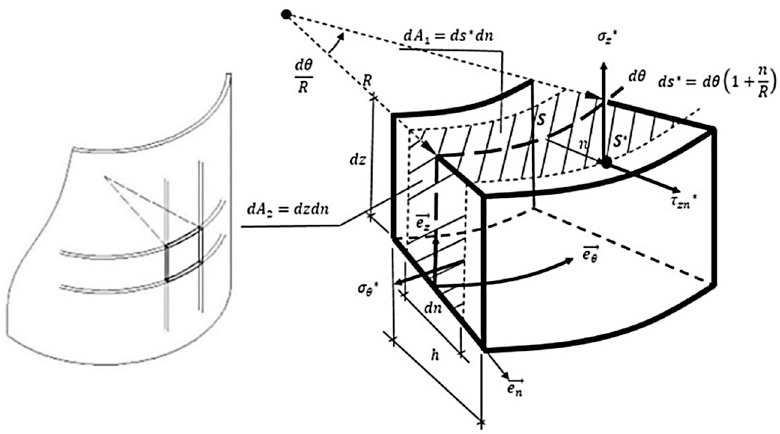
Figure 3. Geometrical details for modeling the shell curvature in the free body diagram of the tunnel ventilation shaft differential slide.